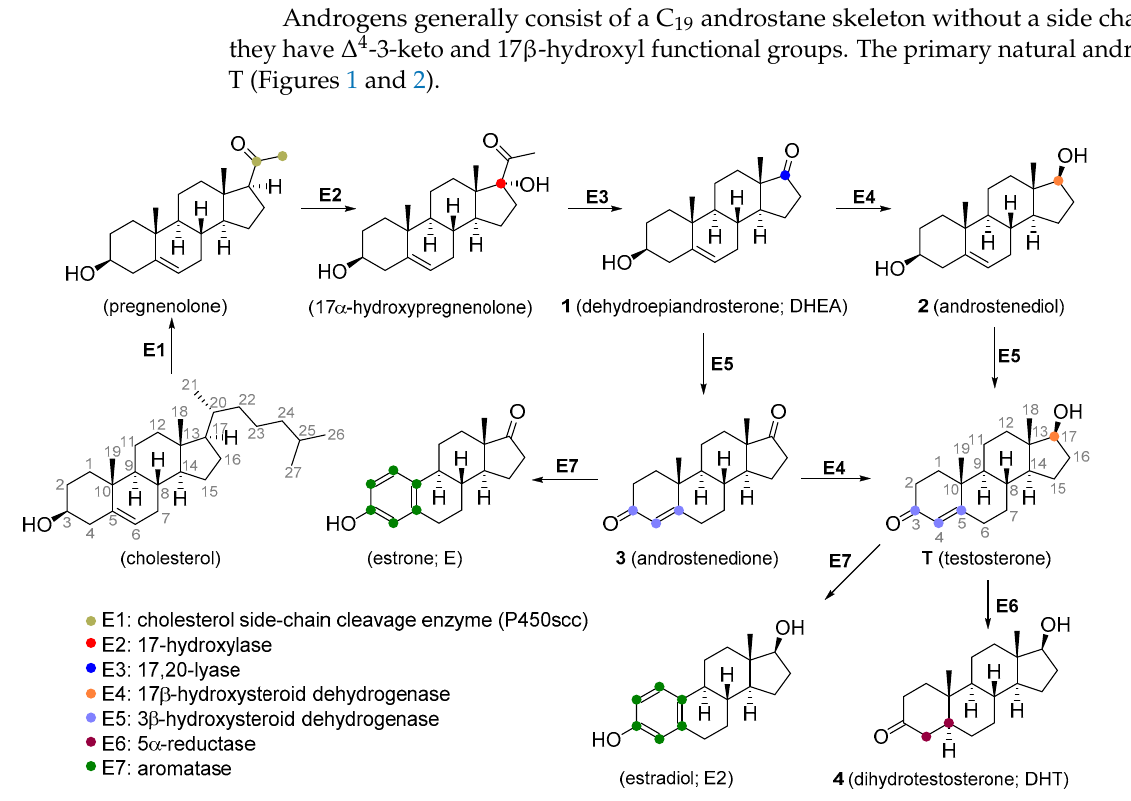
Figure 1. Scheme of testosterone biosynthesis. T is synthesized de novo from cholesterol via several enzymatic transformations where dehydroepiandrosterone (DHEA) 1 , androstenediol 2 , and androstenedione 3 play a key role (Figure 1). T may be subject to further structural changes leading to the production of dihydrotestosterone 4 or estradiol (Figure 1). T can be produced pharmaceutically from androstenolone ( 5 , Figure 2) by the reduction of 17-carbonyl and oxidation of the 3-hydroxyl with the use of necessary protecting groups. This structural conversion